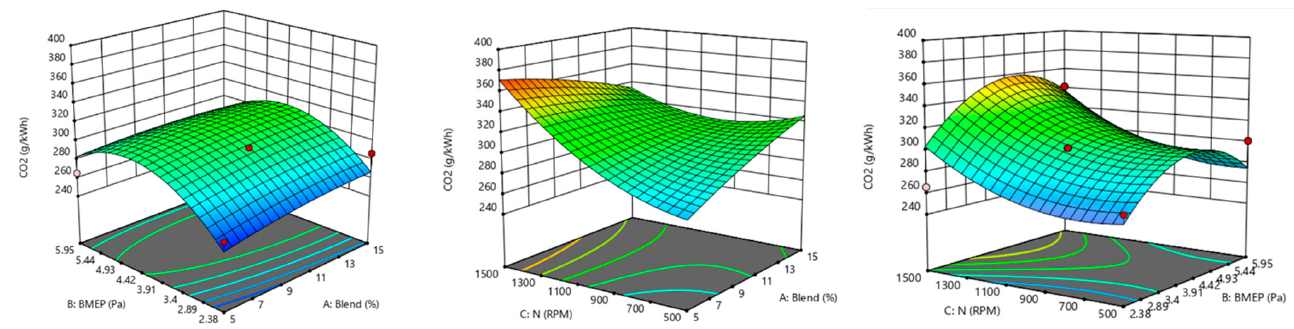
Figure 17. Comparative analysis of maximum CO 2 emission (response to blend-BMEP; BMEP-N; Blend-N).